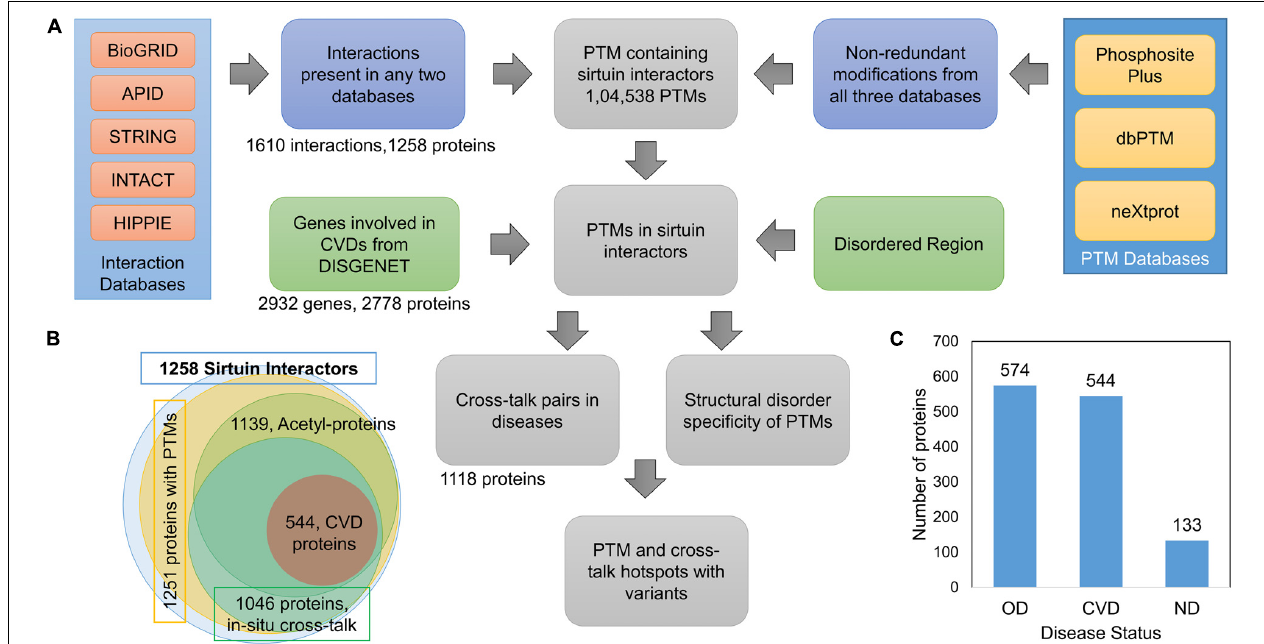
FIGURE 1 | (A) Schematic overview of workflow to extract sirtuin interactors and their PTM sites from different databases. (B) Overview of proteins involved in interactions with SIRTs, the interactors containing PTMs, acetyl-containing proteins, and proteins with in situ crosstalks. It also shows proteins known to be associated with cardiovascular diseases (CVDs). (C) Proteins in the SIRTUIN interaction network to be associated with CVDs, other diseases (OD), and no-disease (ND).